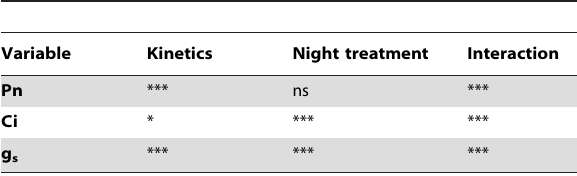
Table 1. Results of two-way ANOVA of the impact of night temperature on gas exchange